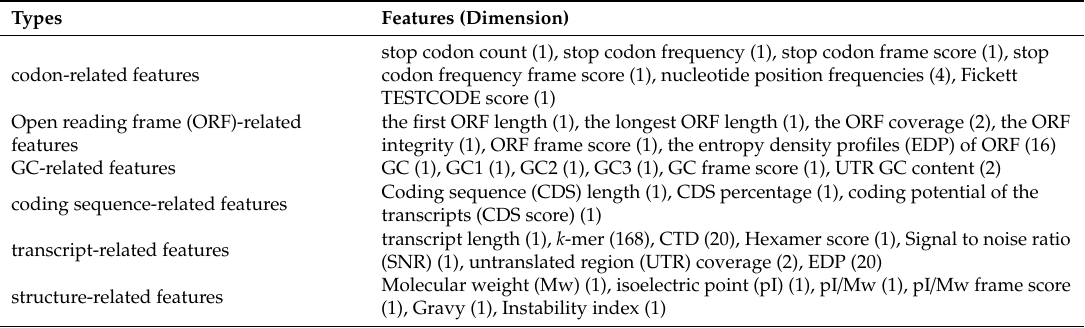
Table 2. All features considered in this paper and their